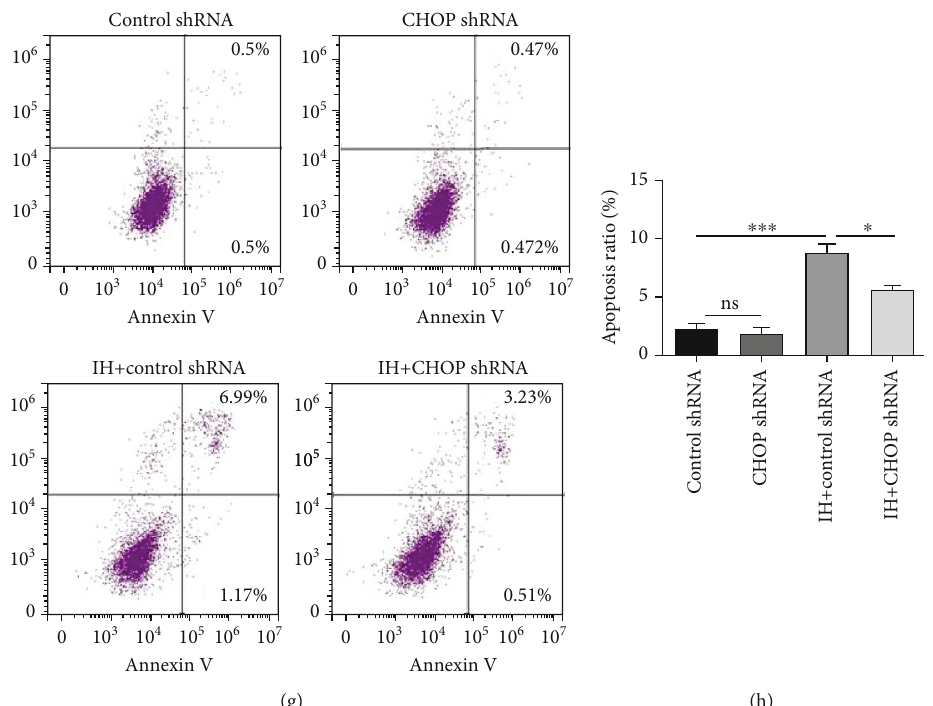
Figure 4: Knockdown of CHOP rescued IH-induced apoptosis via the mitochondrial pathway. (a) Inhibition of CHOP reduced the expression of Bim and cleaved caspase-3, which was increased after IH treatment in the PC12 cell line. (b) The pooled data from each group are summarized ( n = 3 ). (c) The western blot results showed that CHOP shRNA decreased the expression of Bax and Bak and elevated the expression of cytochrome C in mitochondria. Statistical data from three animals for each group are summarized in (d) ( n = 3 ). (e) Representative western blots showing that the reduced expression of Bax and Bak and increased expression of cytochrome C induced by IH treatment were prevented by CHOP shRNA. (f) The pooled data from each group are summarized ( n = 3 ). (g) Annexin V-FITC/PI staining measured by fl ow cytometry revealed that IH signi fi cantly increased the apoptotic cell ratio, which was decreased by CHOP shRNA. (h) Quanti fi cation of the results of fl ow cytometry. ∗ P < 0 : 05 ; ∗∗ P < 0 : 01 ; ∗∗∗ P < 0 : 001 ; ns: not signi fi